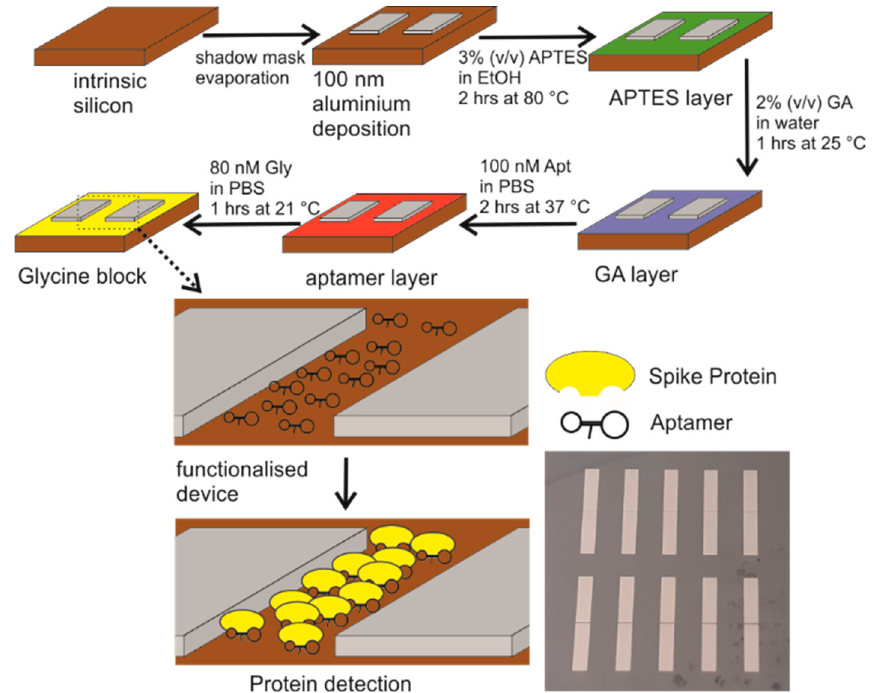
Figure 1. Schematic of the functionalisation process and subsequent detection of the spike protein. An aluminium contact is deposited on an intrinsic silicon sample. The device is functionalised with APTES, glutaraldehyde (GA), aptamer and glycine molecules in this order. The glycine is aimed at terminating any unbound aldehydes, which might create non-specific binding sites. In the final step, the process of detection is visualised inside the electrode gap. For clarity the aptamers and protein are only shown in the area between the electrodes; however, they are present everywhere on the silicon. At the bottom right is a photograph of the actual devices.